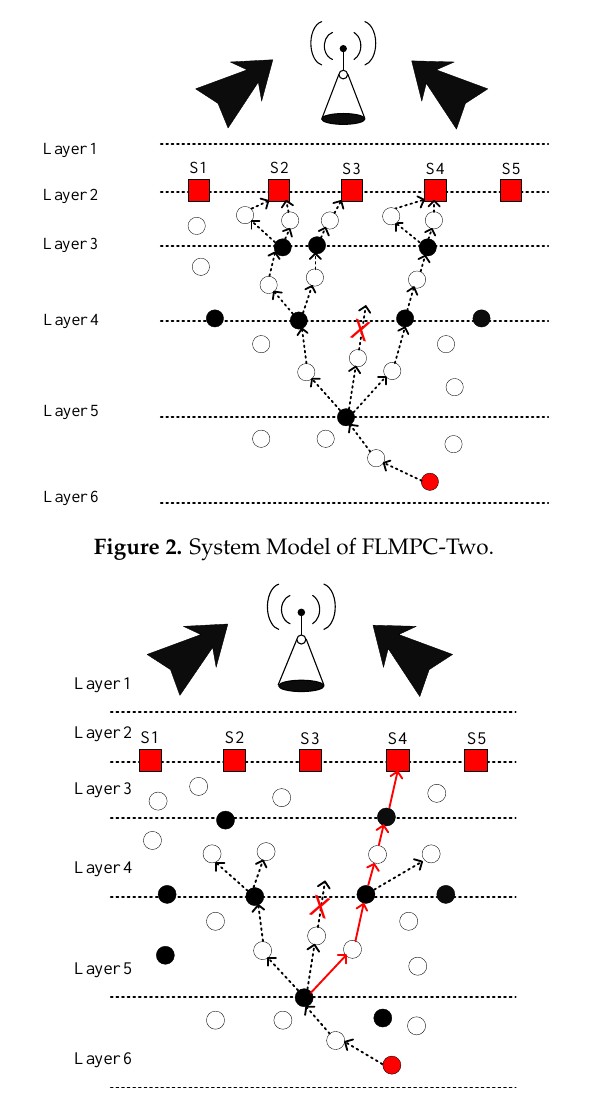
Figure 3. System Model of